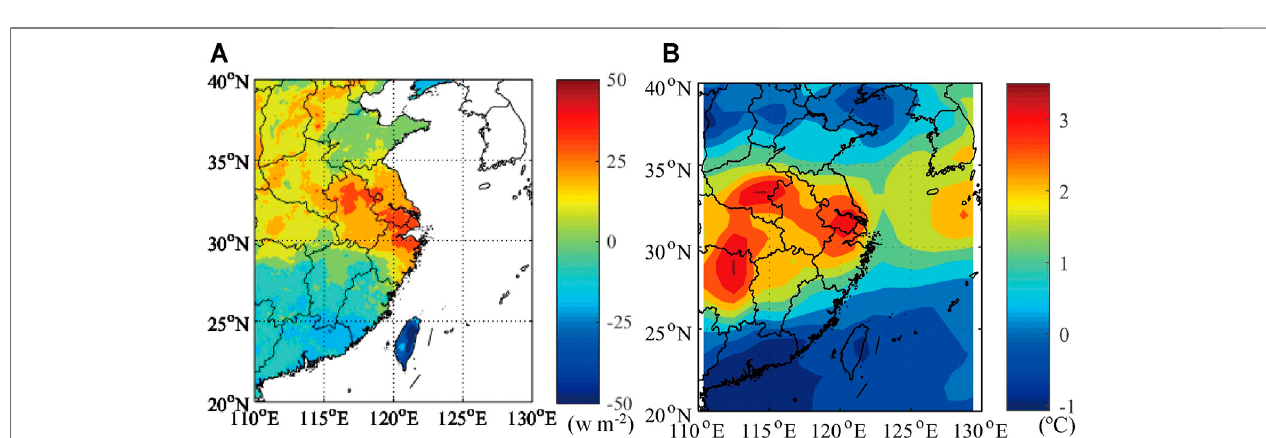
FIGURE 9 | The differences of solar radiation (A) and 2 m air temperature (B) over the YRD between the summer in 2013 and 2015.